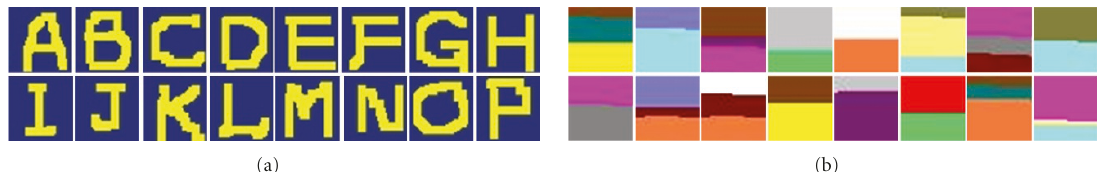
Figure 3: 16 examples of image blocks. “letter” group (a) and “hori” group (b).